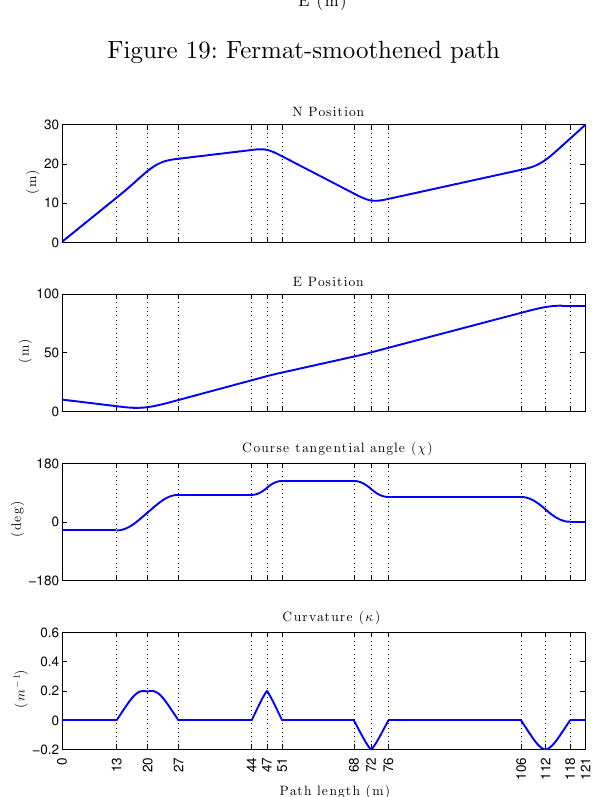
Figure 20: Fermat smoothing path properties